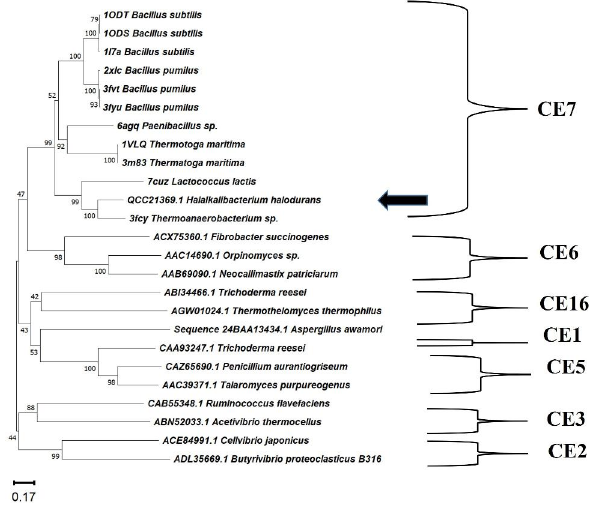
Fig. 1 Neighbor-joining phylogenetic tree, constructed by MEGA 11.0, showing the genetic relatedness of AXE-HAS10 (accession number: QCC21369.1) deduced amino acid sequence of Halalkalibacterium halo- durans strain NAH-Egypt (indicated by an arrow) with respect to other AXE(s) from other species. Numbers on branch nodes represent bootstrap values (1000